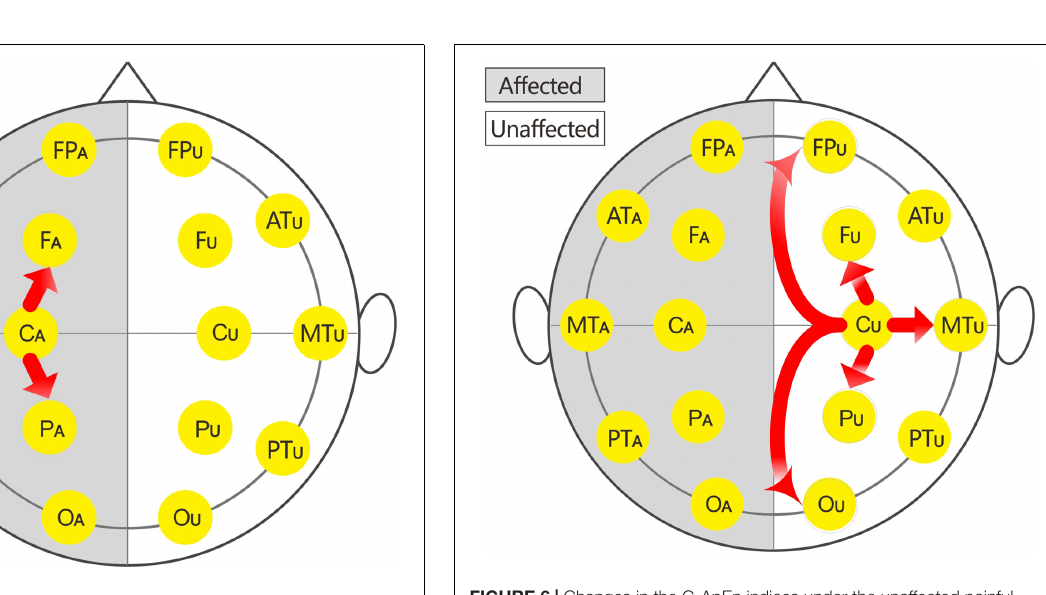
FIGURE 5 | Changes in the cross approximate entropy (C-ApEn) indices under the affected painful stimulus conditions.